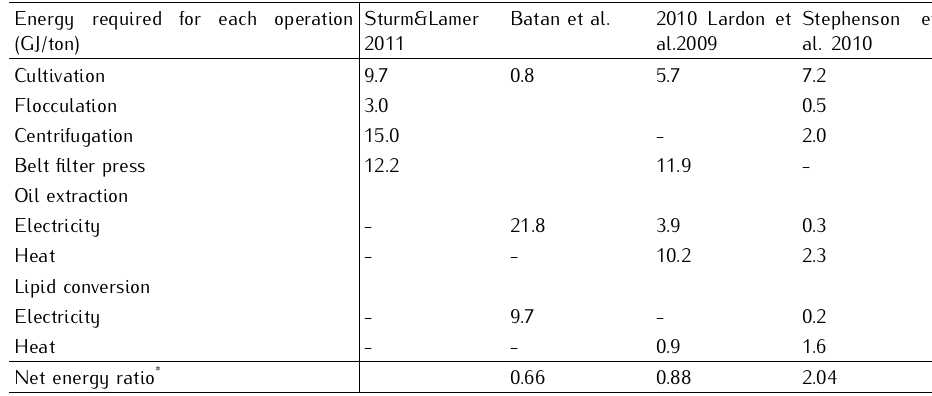
Table 3. Energy inputs and net energy ratios for algal biodiesel production [40, 41, 43, 44] Energy required for each operation (GJ/ton)